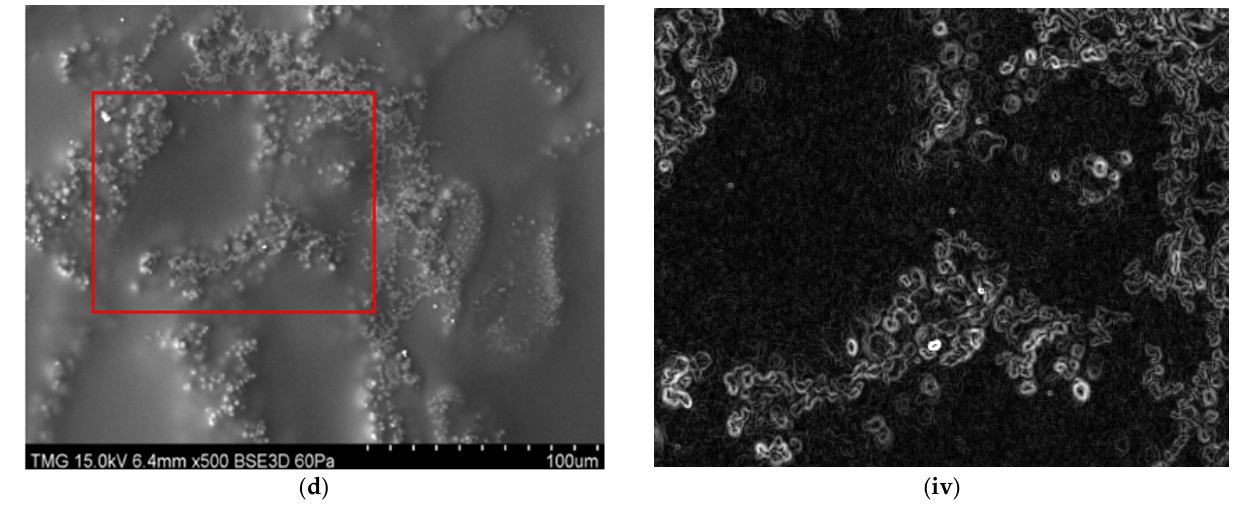
Figure 8. SEM images of starch-based/polyvinyl alcohol/citric acid/glycerol (SPGC) films, ( a ) 0.46 wt% CA (SPGC1), ( b ) 0.92 wt% CA (SPGC2), ( c ) 1.38 wt% CA (SPGC3), ( d ) 1.83 wt% CA (SPGC4); The analyzed ImageJ software images without changing the magnification of SEM images; ( i ) 0.46 wt% CA (SPGC1), ( ii ) 0.92 wt% CA (SPGC2), ( iii ) 1.38 wt% CA (SPGC3), ( iv ) 1.83 wt% CA (SPGC4). As shown in Figure 8, the selected areas of the SEM images analyzed by the open- source ImageJ software package demonstrate the micro-sized clusters of starch granules and the edges of the peaks and depths on the material’s surface. Moreover, the distribu- tion and area of starch clusters on the surface of each material (SPGC1-SPGC4) were cal- culated (Figure 9). The total number of cluster peaks for each sample confirms that the surface becomes smoother as each solution’s citric acid content increases. For example, the total number of peaks on the SPGC1 sample surface was recorded at 115 compared to 52 points on the surface of SPGC4.